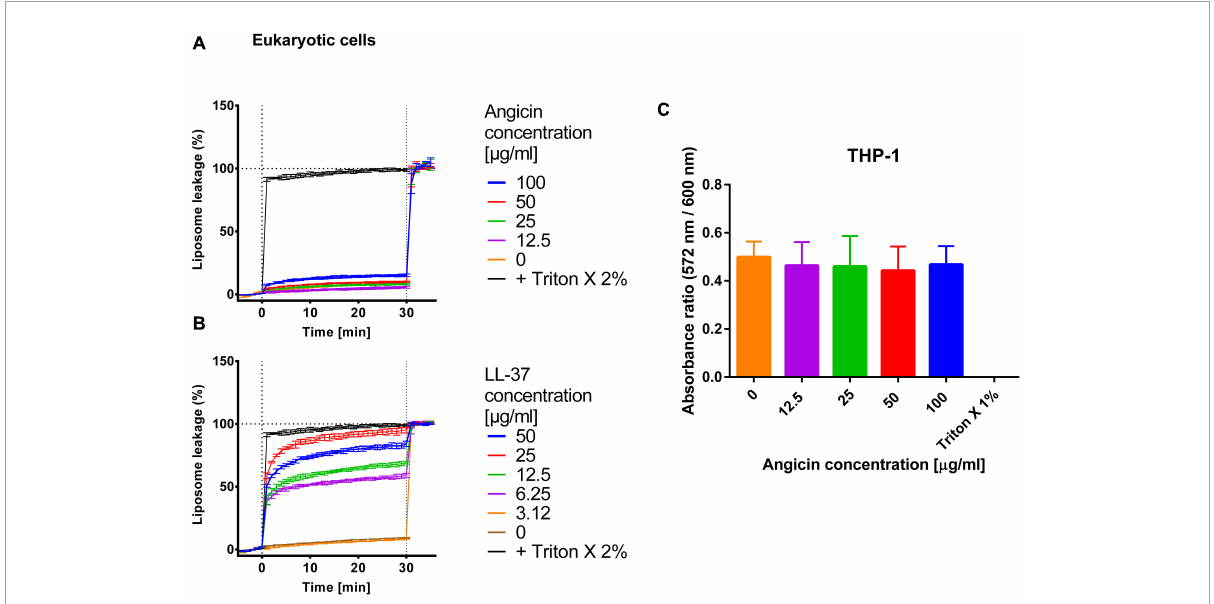
FIGURE6 Effect of Angicin on liposomes and cellular metabolic activity. For liposomes derived from eukaryotic cells baseline fluorescence was measured once per minute for 5 min. Subsequently, Angicin (A) or the AMP LL-37 (B) was added at indicated concentrations and fluorescence increase (indicating membrane rupture) was recorded every minute for 30 min. Triton X-100 was added at a final concentration of 2% to induce total lysis. Background signal was subtracted (signal of liposome prior to addition of compounds) and normalized to fluorescent signal achieved in each well after complete liposome leakage induced by addition of 2% (v/v) Triton X-100. Depicted is the mean ± standard deviation. Three independent experiments were performed. (C) Monocytic THP-1 cell were incubated for 24 h with the indicated Angicin concentrations. Afterward the metabolic activity of cells was measured with a Resazurin assay. A treatment with Triton X was used as a positive control and untreated cells as negative control. A Mann-Whitney- U -test was conducted to test for significant differences. Depicted are mean and standard deviation of five independent experiments each performed in